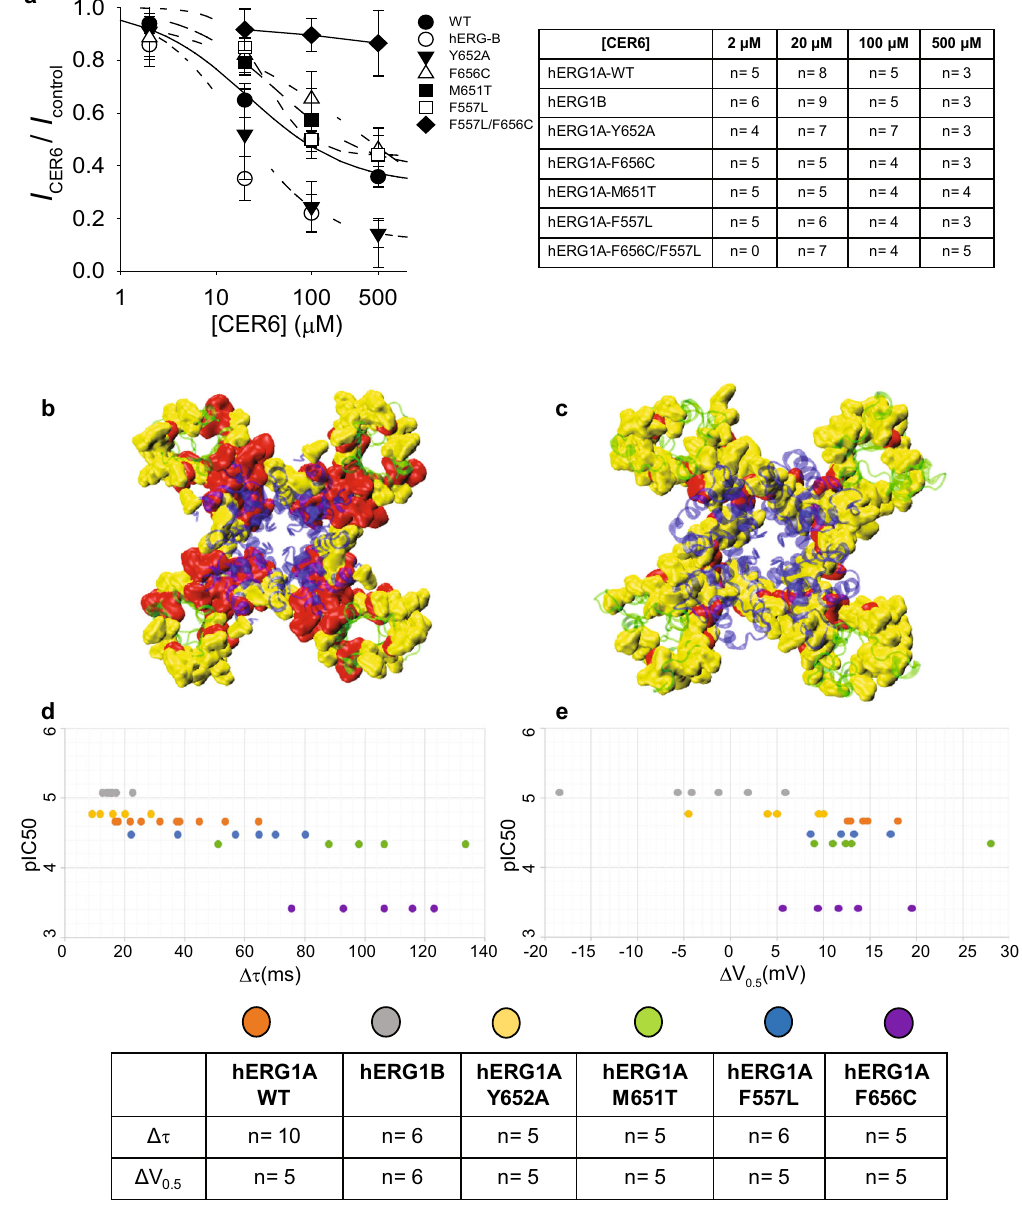
Fig. 3 Effects of ceramide application on conduction and gating properties of hERG1 variants expressed in mammalian HEK cells. a Dose-response relationship for increasing [CER6] = 2, 20, 100, and 500 µ M. Data are represented as mean ± SD. Raw values for residual current are provided in Source Data — Fig. 3a. Panels b and c show the contact mapping for ceramides calculated from CG-MD simulations for hERG1A-WT and hERG1A-F656C/F557L open-state ( n = 4 for both), respectively. The extracellular view of the channel is shown, where the VSDs and the PD are shown as green and blue cartoons, respectively. The residues identi fi ed using the maximum-occupancy criteria are represented with a red surface. The residues identi fi ed through contact-duration but not through maximum-occupancy metrics are highlighted as a yellow surface. A color-coded list of residues is provided in Source Data — Fig. 3b, c. For each system, the contact-duration and maximum-occupancy metrics were calculated considering the tetrameric structure of the channel, totalling 4 × n replicas per-residue (see Source Data — Supplementary Figs. 5 and 6). The last 8 microseconds of each replica were used for analysis. Panels d and e show scatter plots for pIC50 ( − log[IC 50 ]) vs the change ( Δ = Control − Cer) in deactivation τ and activation V 0.5 after ceramide application, respectively (see Source Data — Supplementary Fig. 2b, c). The scatter plots for pIC50 vs τ and activation V 0.5 after ceramide application are shown in Supplementary Fig. 13a, b, respectively. Deactivation τ values in d were measured at − 100 mV, except for hERG1B ( − 50 mV). [CER6] = 20 µ M was used for all measurements shown in panels d and e , except for the mutant hERG1A-F656C (400 µ M). The legend for scatter plots for d and e is shown at the bottom: hERG1A- WT (orange), Y652A (yellow), M651T (green), F557L (blue), F656C (purple), and hERG1B (gray). The tables in a and d, e indicate the number of independent experiments (n), each performed on a different